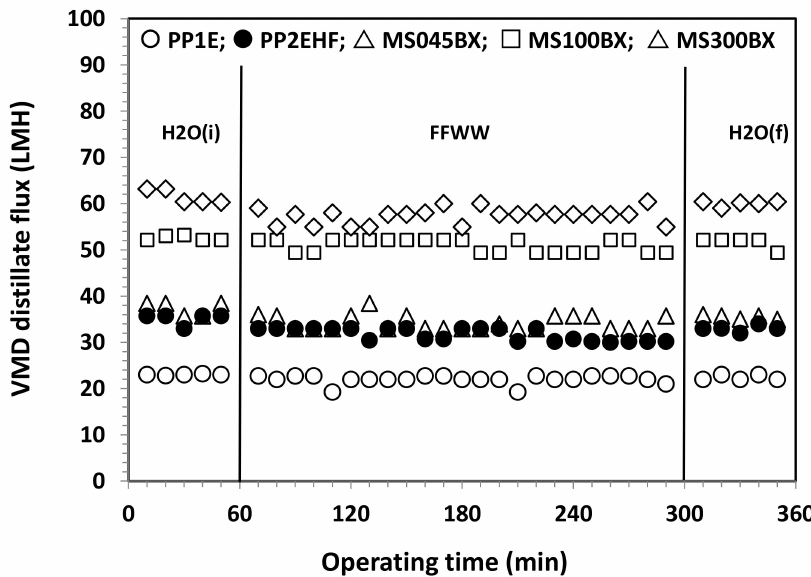
Figure 7. VMD distillate flux as a function of the operating time for PP and PTFE MS membranes.